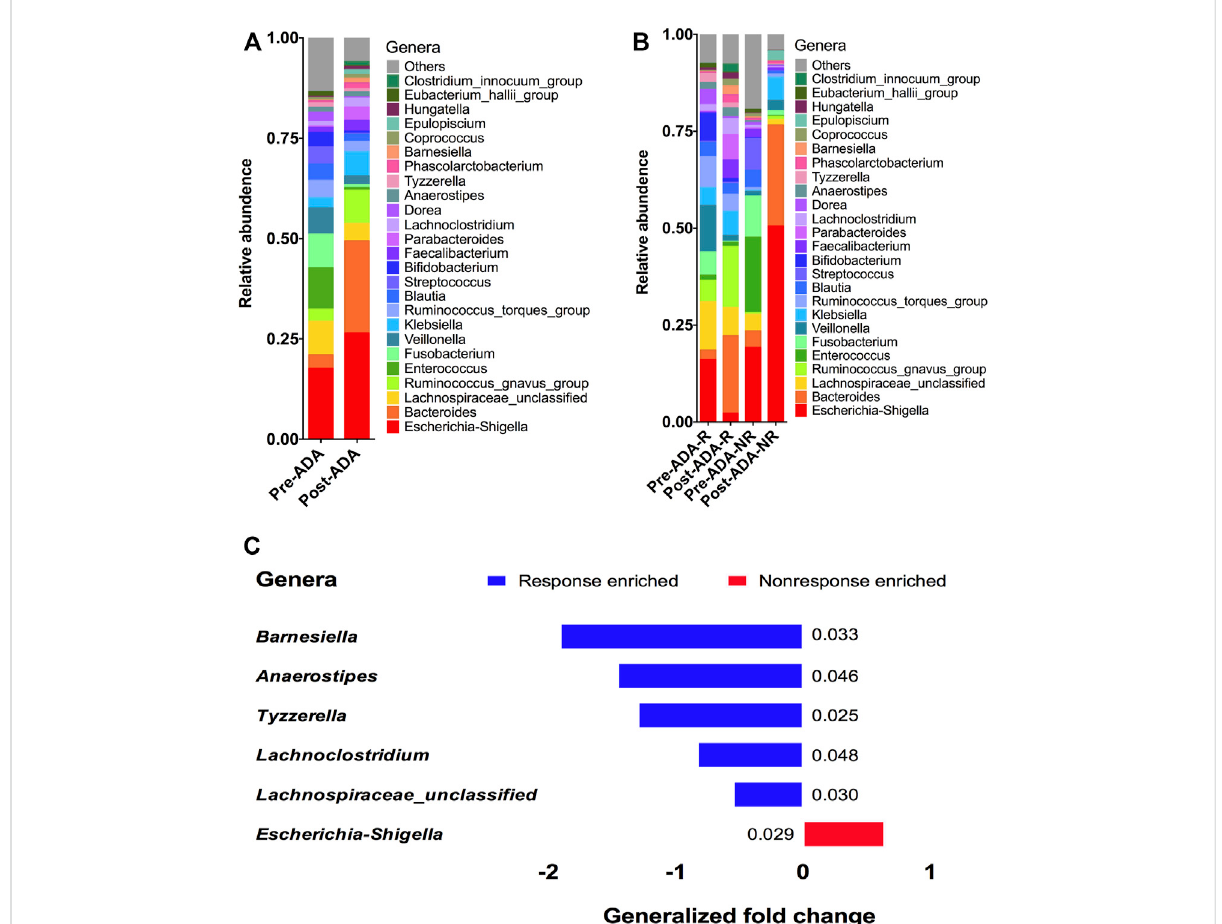
FIGURE 5 Relative proportions of bacterial genera were compared between pre-ADA and post-ADA (A) and were also compared in between Pre-ADA-R, Post-ADA-R,Pre-ADA-NR,andPost-ADA-NR (B) .Thegeneracolumnsdisplaythetaxonomyinformationatthegenuslevel. p valueswerecomputed using a two-sided blocked Wilcoxon rank-sum test and the exact p values are presented beside the barplots. Generalized fold change (see the Materials and Methods section) is indicated by color gradients. The generalized fold change > 0, enriched in nonresponsive adalimumab samples; generalized fold change < 0: enriched in responsive adalimumab samples. (C) . Pre-ADA-R, responsive pre-adalimumab samples; Post- ADA-R, responsive post-adalimumab samples; Pre-ADA-NR, nonresponsive pre-adalimumab samples; Post-ADA-NR, nonresponsive post- adalimumab